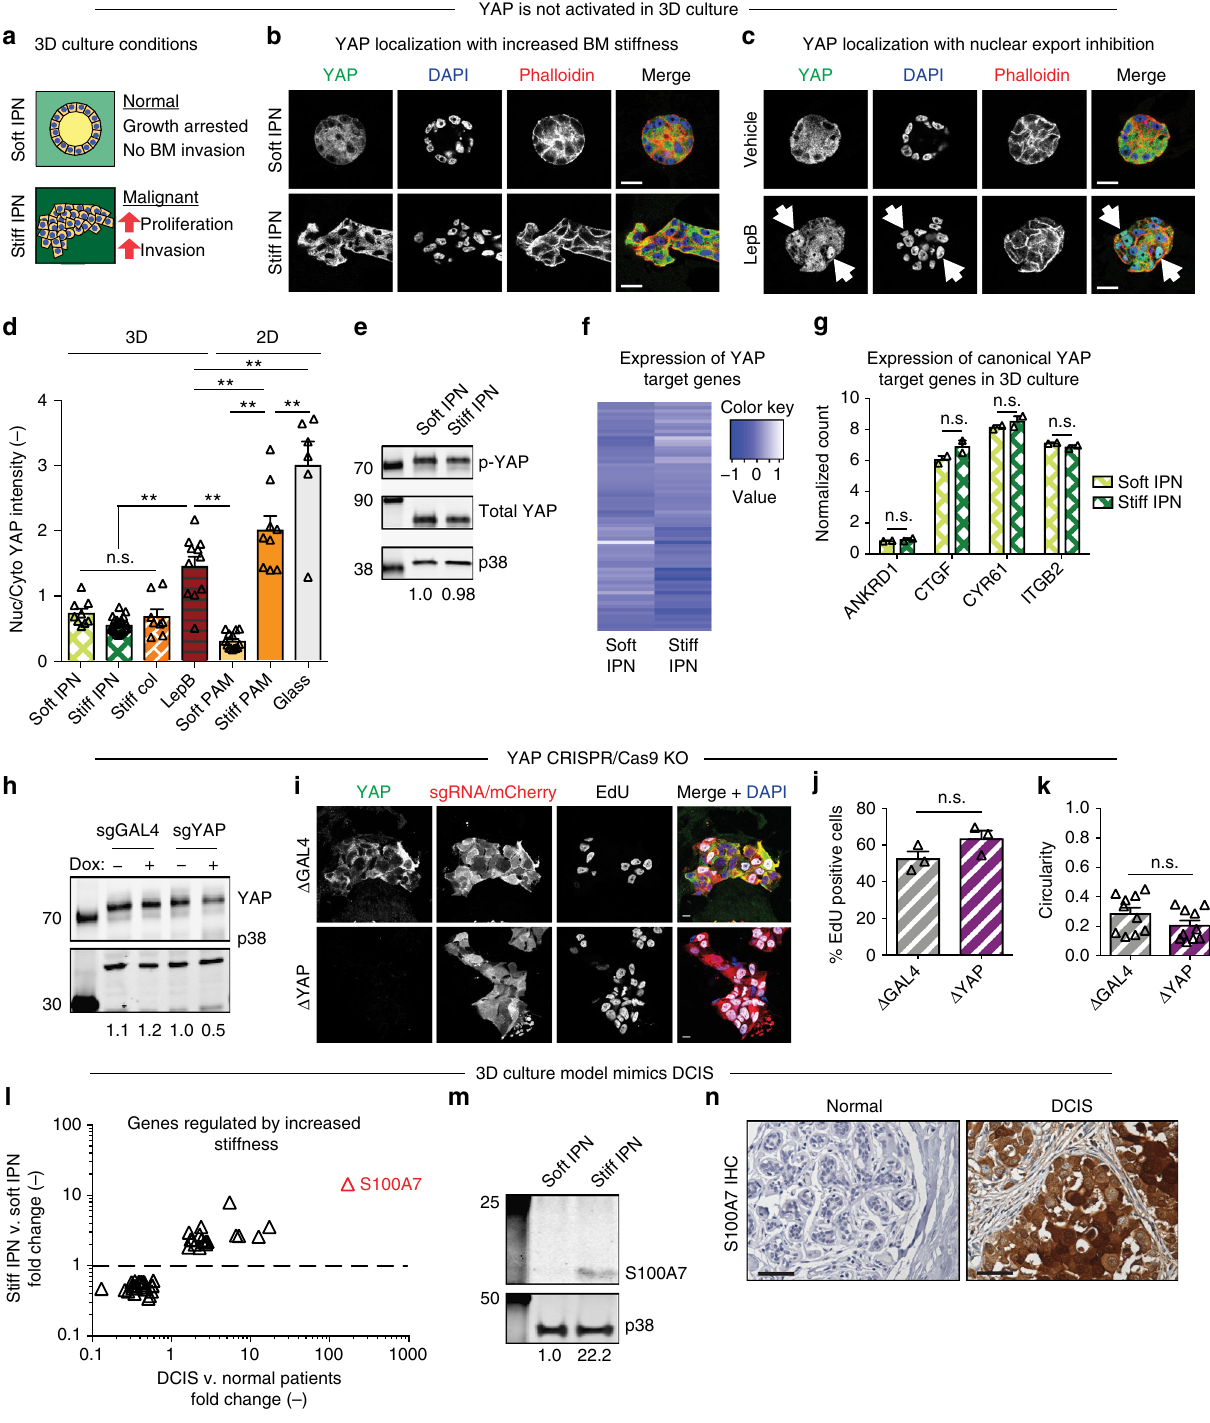
compared to untreated and MCF10A::Cas9/sg GAL4 controls (Supplementary Figure 10 – 12). Bioinformatics, small molecule (Fig. 2h; and Supplementary Fig. 7). As Cas9 induction results in inhibitor, inducible CRISPR/Cas9 KO, and overexpression a mixed population of KO cells, only cells veri fi ed for Δ YAP by IF experiments strongly implicate STAT3 and p300 as mechan- were assayed for mechanotransduction (Fig. 2i). Interestingly, otransducers during breast cancer (Supplementary Figs. 10 and Δ YAP cells did not reduce stiffness-induced invasion (Fig. 2j) or 11). Taken together, our analyses of YAP and TAZ nuclear proliferation (Fig. 2k) compared to Δ GAL4 controls. As YAP did localization, YAP phosphorylation state, expression of YAP target not regulate mechanotransduction during breast cancer pro- genes, and inducible CRISPR/Cas9 knockout cells conclusively gression, we explored other transcriptional regulators whose tar- show that YAP does not mediate mechanotransduction in 3D get genes were identi fi ed by RNA-seq to be modulated by stiffness culture. NATURE COMMUNICATIONS| (2019) 10:1848